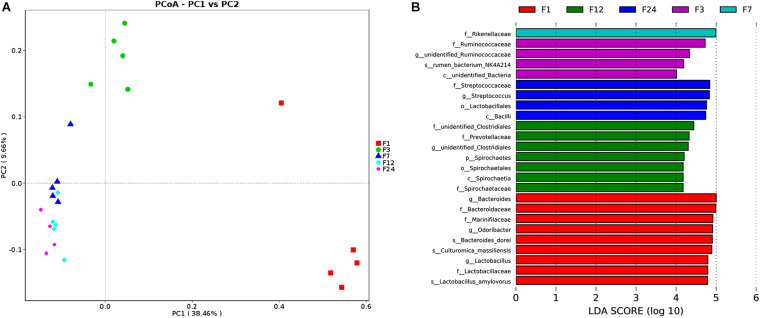
Alterations in fecal microbiota of donkeys at different ages. Principal coordinate analysis (PCoA) showing phylum-level differences (A). Histogram showing taxa with statistically significantly linear discriminant analysis (LDA) values of donkeys at different ages (B). f, family; g, genus; s, species; o, order.